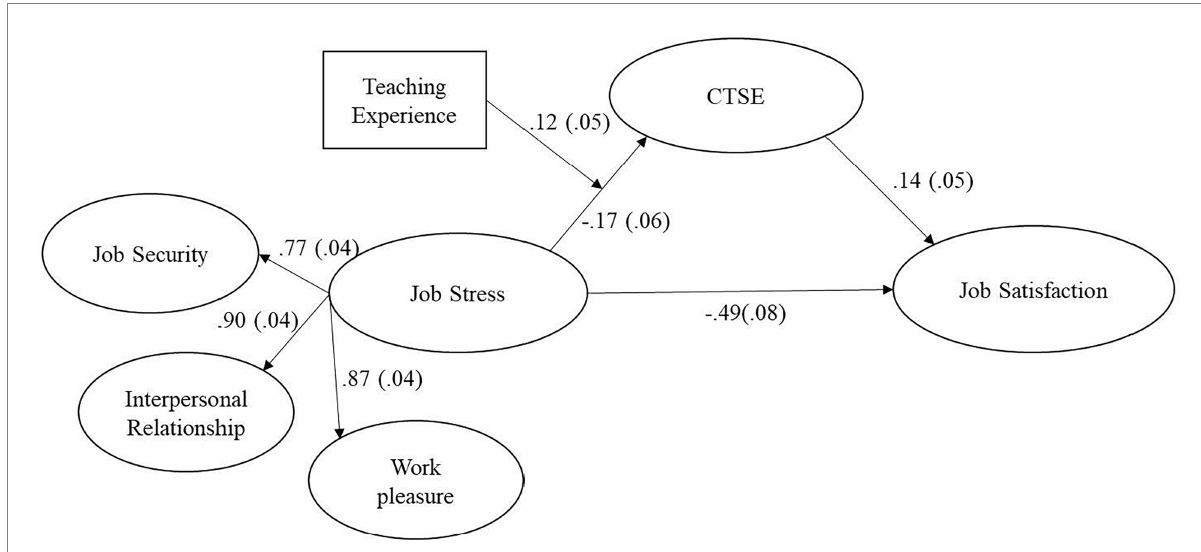
FIGURE 3 Final mediation model with teaching experience. Standardized coefficients are presented on the paths. All measurement indicators, error terms, variances, and covariances are omitted in this